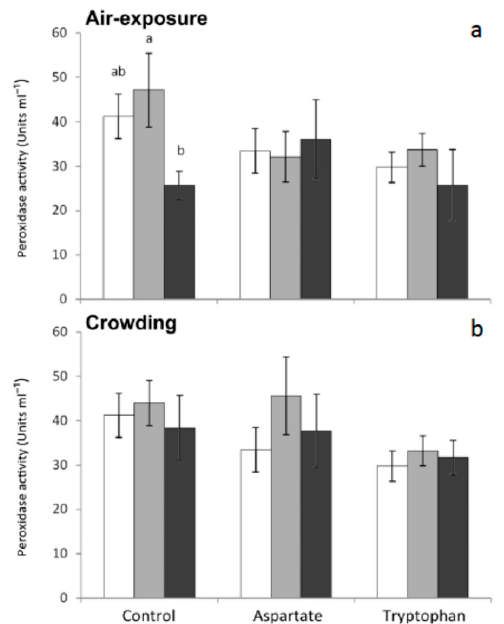
Figure 3. Peroxidase activity (units mL − 1 ) in fish stressed by ( a ) air-exposure or ( b ) crowding. Results are shown as mean ± standard error. Different letters indicate significant differences among non-stressed fish (white bars), 1 h post stress (grey bars) and 6 h post stress (black bars). Differences were considered significant when p < 0.05.